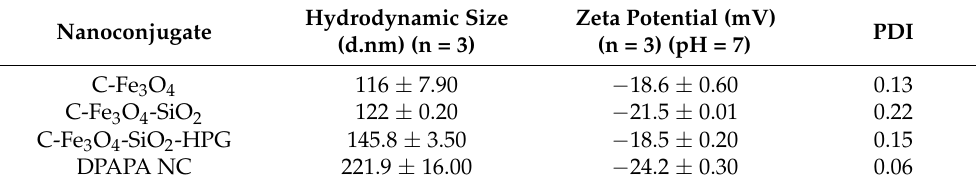
Table 1. Hydrodynamic sizes and zeta potentials of C-Fe 3 O 4 NPs and nanoconjugates (n = 6).